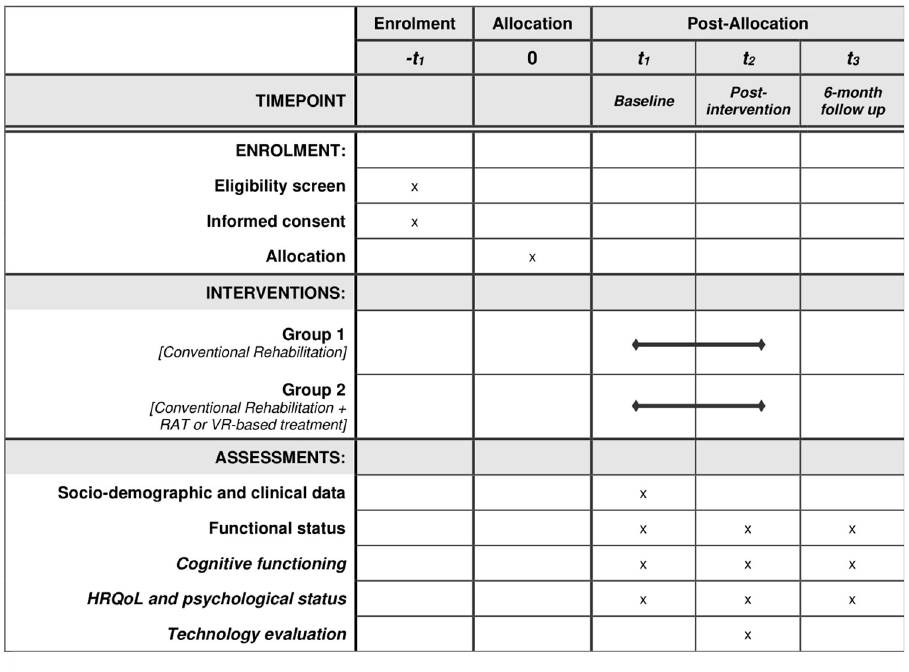
Fig 1. SPIRIT schedule of enrolment, interventions, and